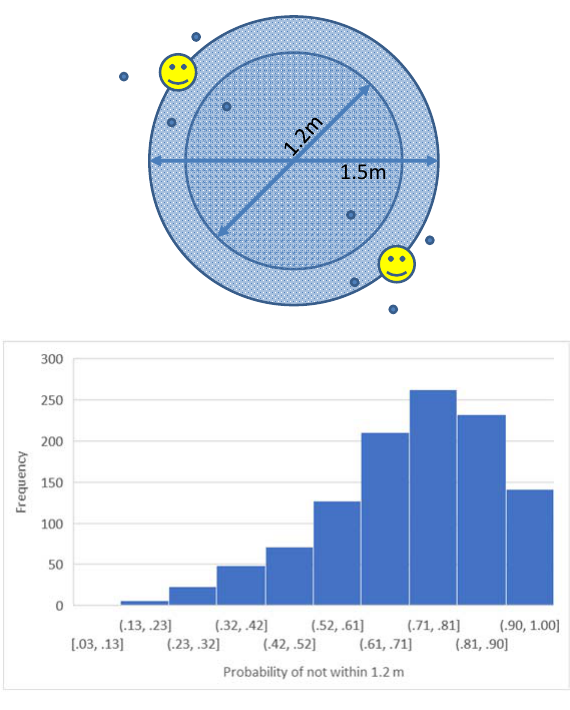
Figure 4. The case when the true distance is 1.5